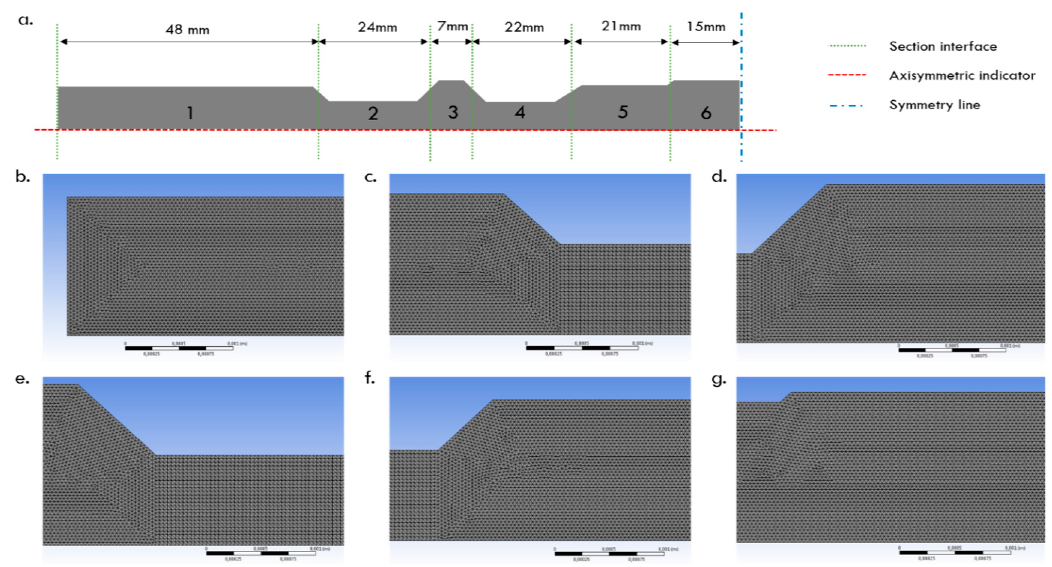
Figure 6. Computational domain for the model with the asymmetrical assumption (red line). The heights of the sections correspond to the radius of the components in the experimental setup. ( a ) Schematic of the six main sections on the left half of the geometry. The right half (from the blue dotted line) is symmetrical to the left one. ( b ) Section 1 represents the first medical tubing with a height of 1.4 mm. ( c ) Section 2 corresponds to the first insert with a height of 0.9 mm. ( d ) Section 3 corresponds the O-rings with a height of 1.6 mm. ( e ) Section 4 corresponds to the second insert. ( f ) Section 5 is the second medical tubing. ( g ) Section 6 represents one half of the SIS-based vascular graft with a height of 1.5 mm. The section interfaces were smoothed out with the aid of 45° chamfers along the computational domain to approximate the transition between components of the experimental setup. The final meshes of each section are shown in panels ( b – g